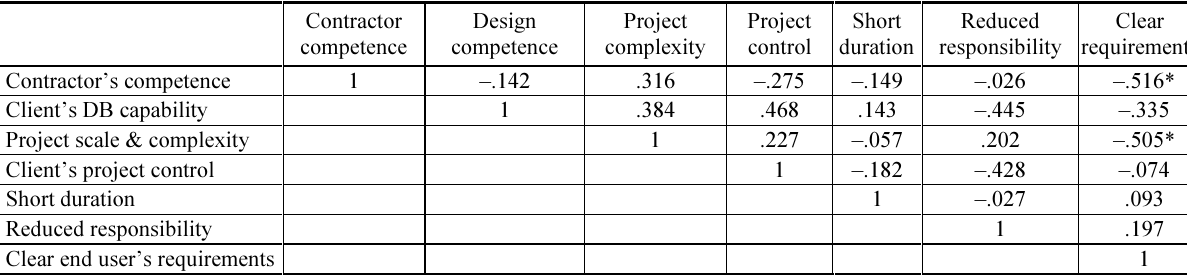
Table 8. Correlations matrix among the top eight selection